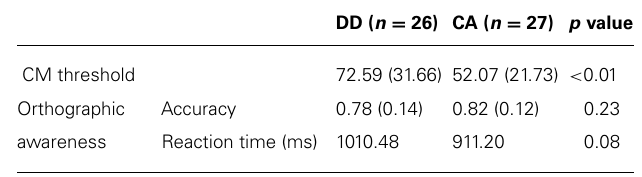
Table 2 | Performance in CM detection task and orthographic awareness test of dyslexics and age-matched